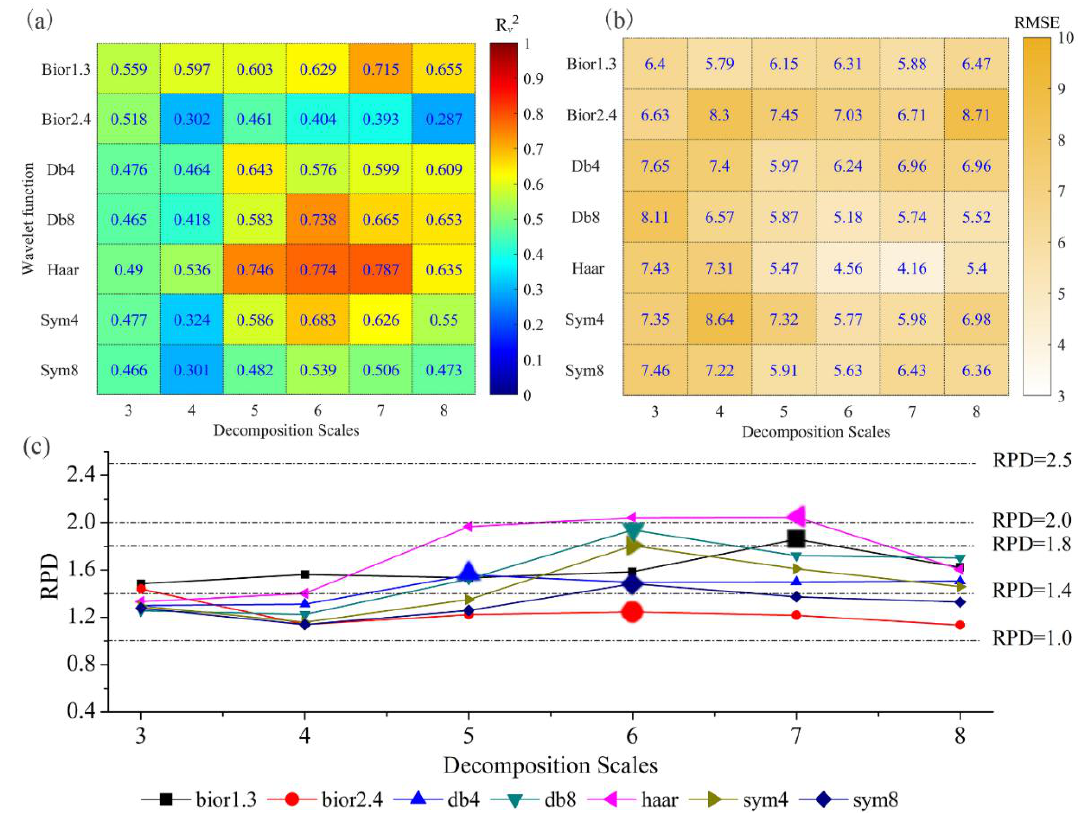
Figure 5. Coefficients of determination ( R v 2 ) ( a ), root mean square error (RMSE) ( b ) and relative percentage deviation (RPD) ( c ) between the laboratory-measured CECs and the DWT–PLS predictions on the CEC validation dataset.